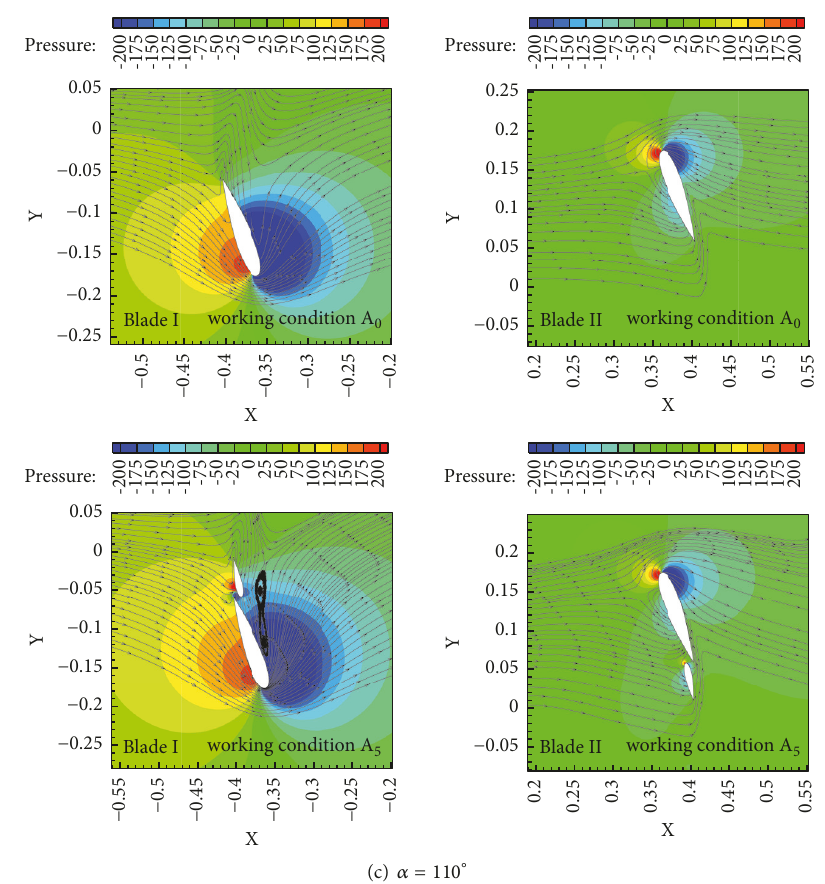
Figure 8: Streamline and pressure contours around wind turbine blade of working condition